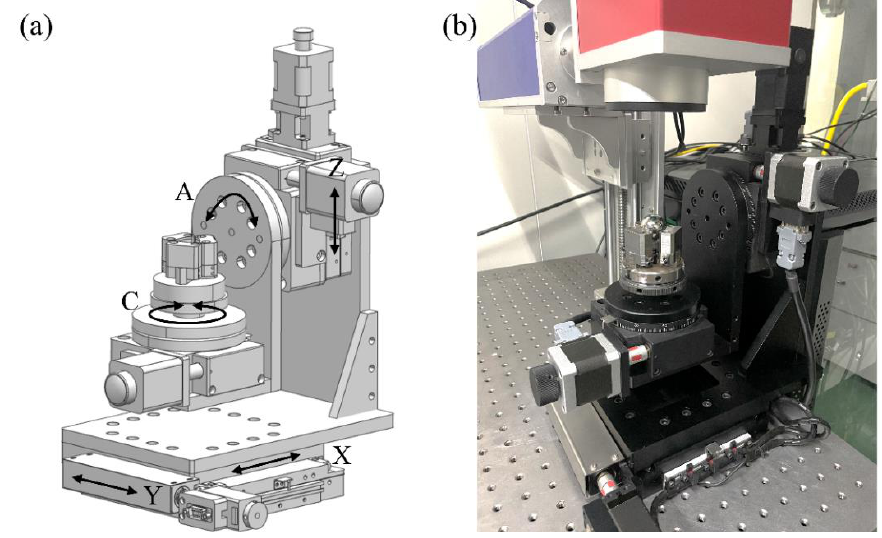
Figure 1. Schematic illustration of the MALM configuration.